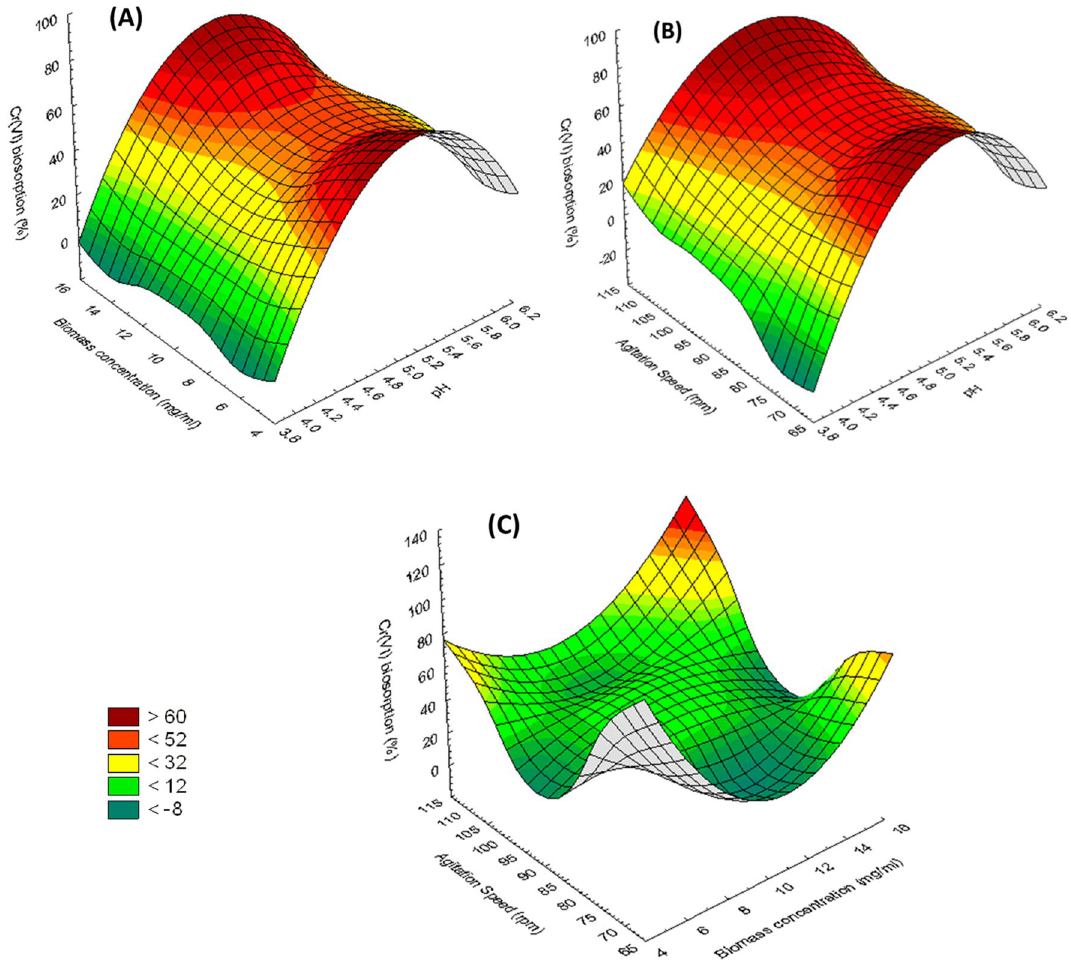
Figure 6. 3-D surface plots showing the effect of the interaction between (A) pH and biomass concentration (mg/ml), (B) pH and agitation speed (rpm) and (C) biomass concentration (mg/ml) and agitation speed (rpm), on Cr 6+ biosorption (%) by S. rochei